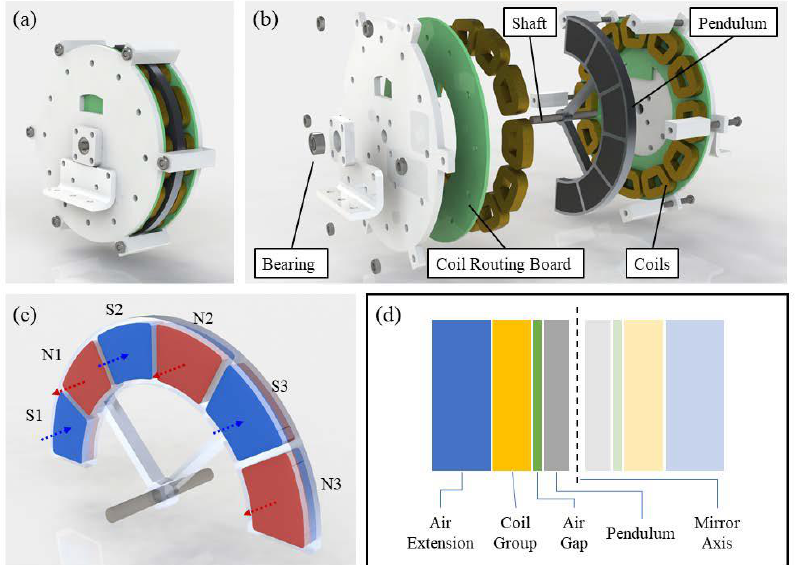
Figure 4. Structure design of a low-frequency vibration energy harvester: ( a ) assembly diagram of an energy harvester; ( b ) explosive view of an energy harvester; ( c ) magnetic field configuration for the eccentric rotor; ( d ) framework diagram of the finite element analysis (FEA) model ([35] CCBY).